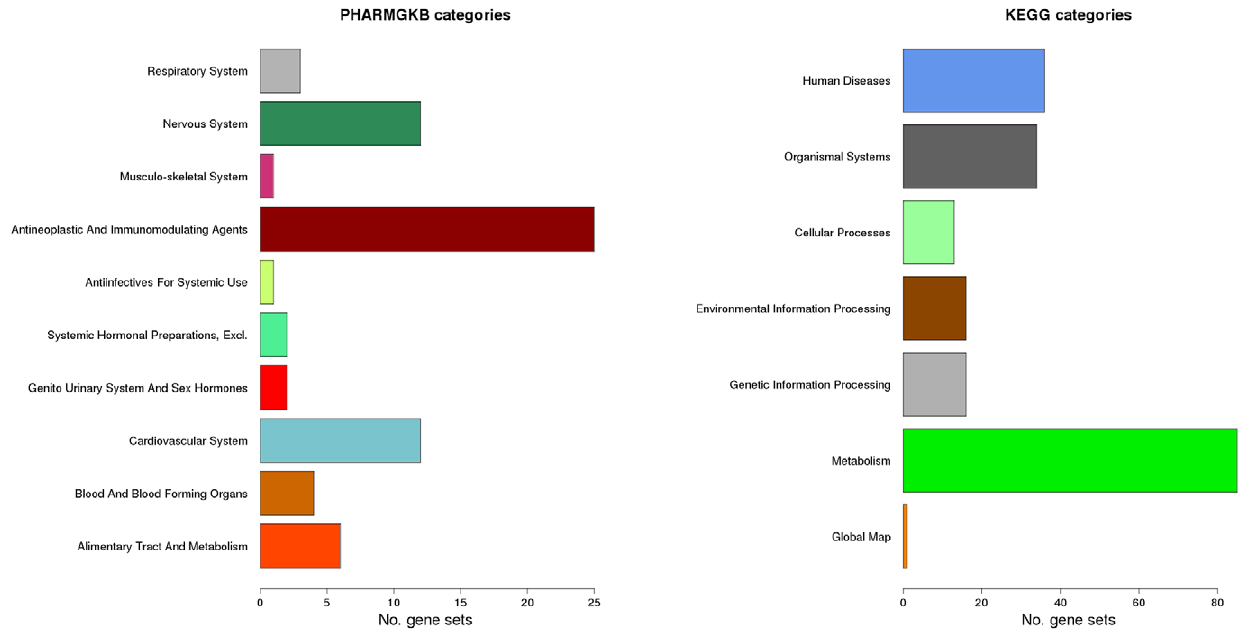
Figure 1. Barplots for number of GSs in PharmGKB and KEGG categories. doi:10.1371/journal.pone.0043301.g001 PLOS ONE |